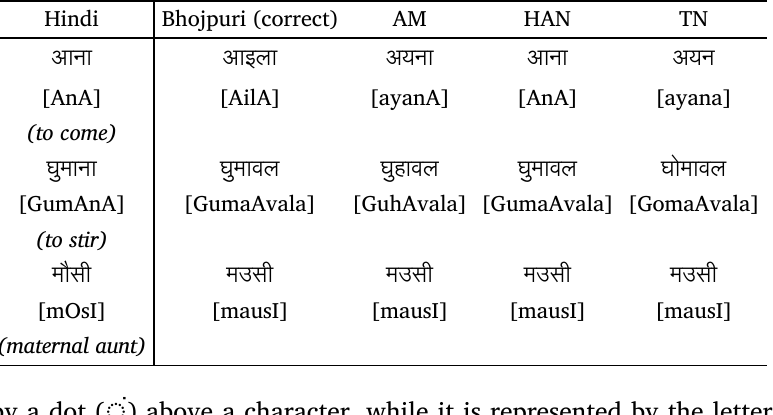
Table 7: Handling vowels